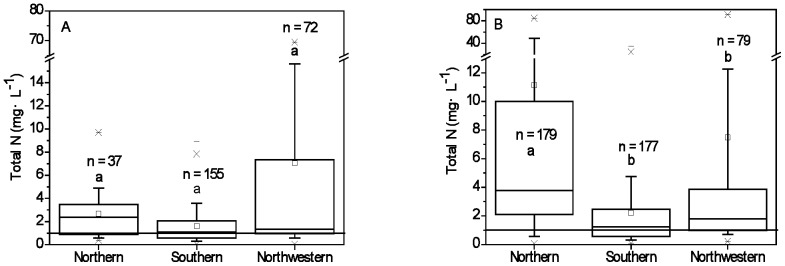
Total nitrogen concentrations of still surface water (A) and flowing surface water (B) under agro- and oasis agro- ecosystems in northern, southern and northwestern areas.The illustrations about Box plots are the same as those in figure 2.